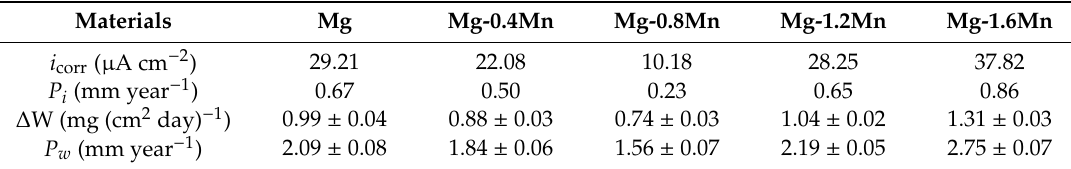
Figure 3. ( a ) Potentiodynamic polarization curves and ( b ) weight loss after immersion for 168 h of the SLMed Mg- x Mn. Table 2. Electrochemical data and immersion data of the SLMed Mg- x Mn. Materials